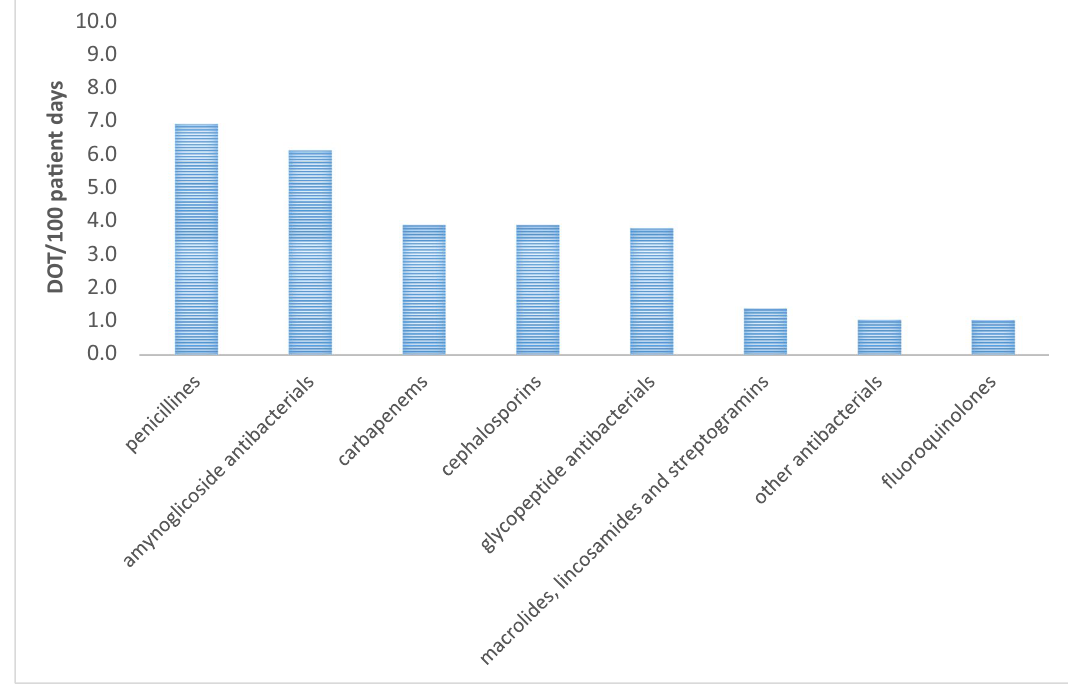
Figure 2. DOT/100 patient days by antibiotic drugs provided for therapeutic purposes. Only antibiotic drugs with more than 1 DOT/100 patient days are shown in the graphic.